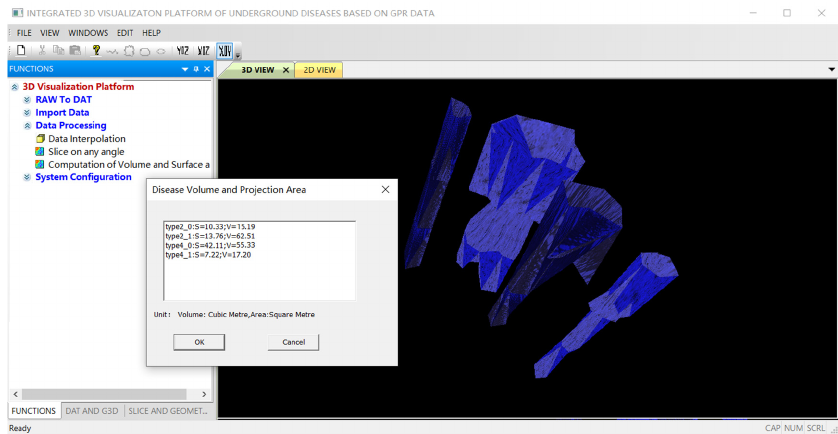
Figure 15. Estimation of volume and surface area.